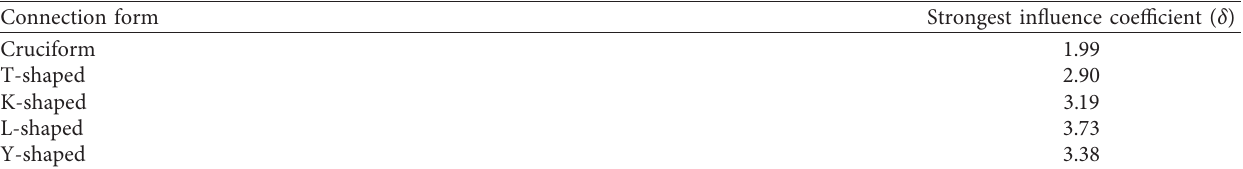
Table 19: Strongest influences of different connection forms.